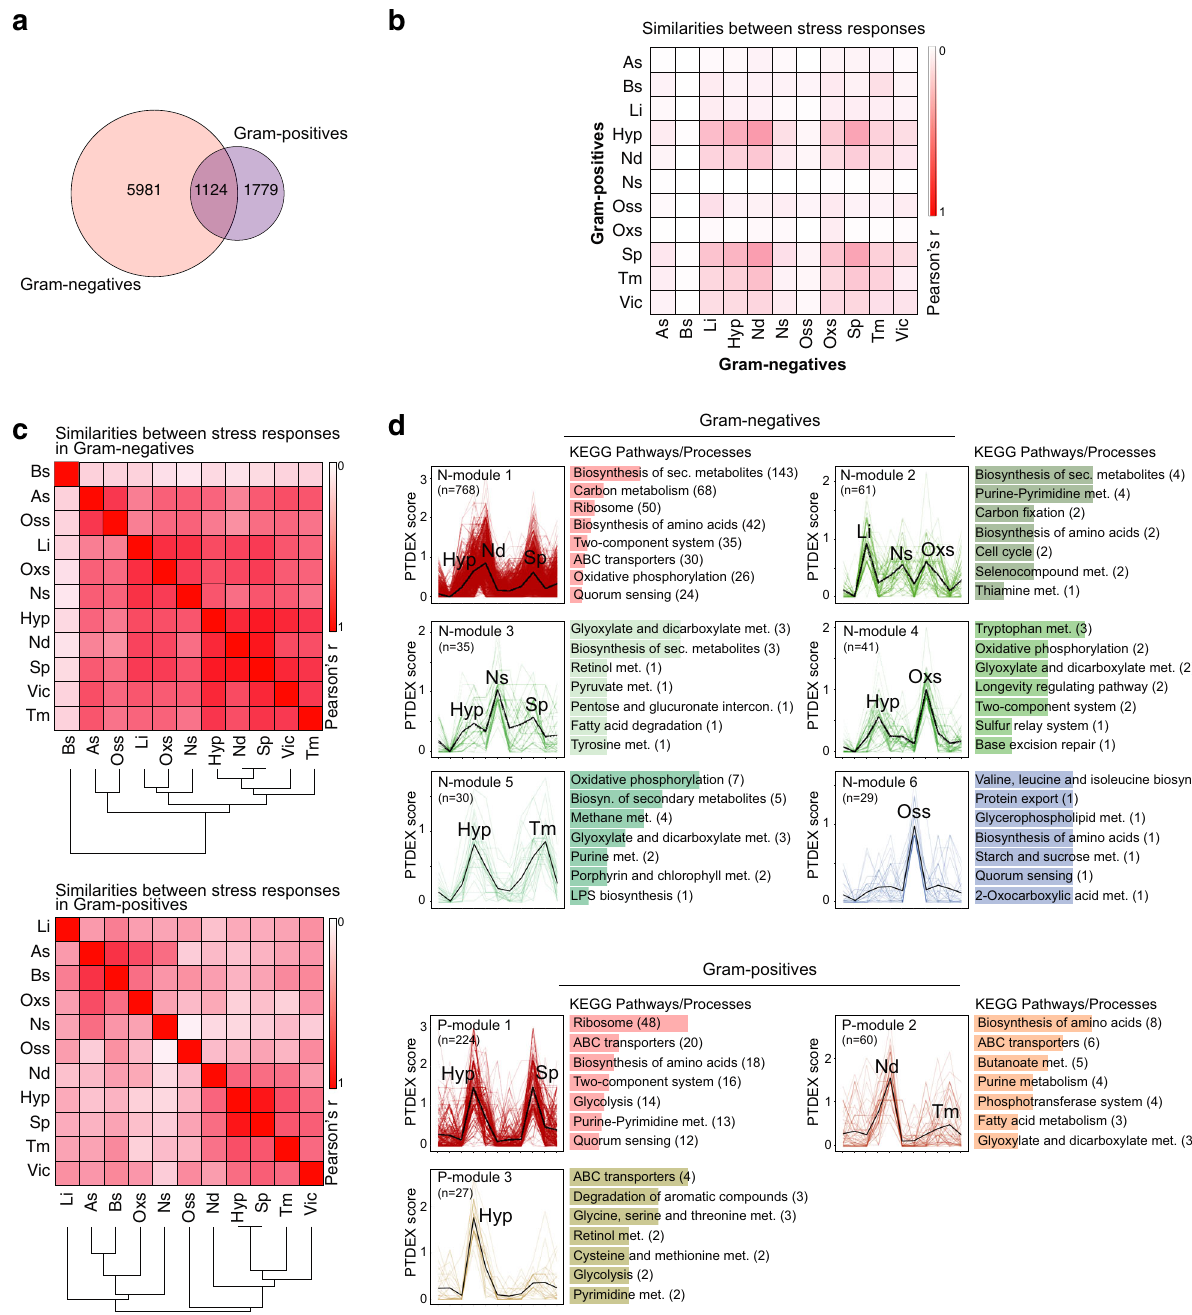
(3)Degradation of aromatic compounds (3) (2)Glycine, serine and threonine met. (2)Retinol met. (2)Cysteine and methionine met. (2)Glycolysis Pyrimidine met. Fig. 3 Gram-negative and -positive bacteria exhibit distinct responses. a Venn diagram of individual and shared PGFam groups with a PTDEX score >0 in at least one of the stress conditions. Venn diagram was generated with http://bioinformatics.psb.ugent.be/webtools/Venn/. b Heat map showing degree of similarity between responses to different stresses in Gram-negative and -positive bacteria. The similarity was calculated using the Pearson correlation coef fi cient of PGFam groups PTDEX scores in each condition. c Heat map showing degree of similarity between responses to different stress conditions in Gram-negative and -positive bacteria. Similarities were calculated as in b and the similarity distances shown in a dendrogram. d Modules generated by CemiTool showing conditions that involve similar regulation of gene groups with high PTDEX scores in Gram-negative and -positive bacteria. n indicates number of PGFam groups within each module. The most enriched KEGG pathways/processes for each module are shown with the number of gene groups indicated in brackets. See also Supplementary Data 5 and